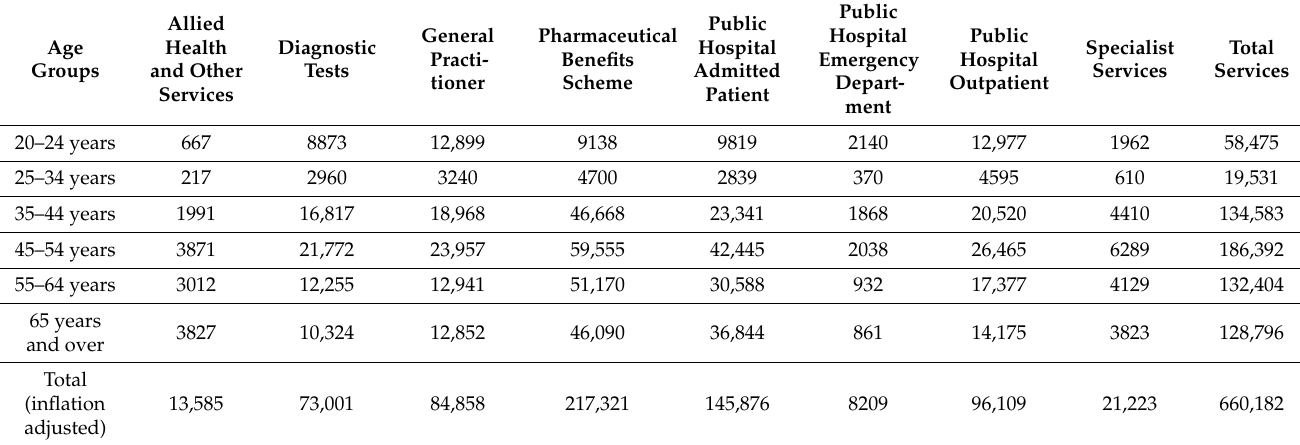
Table A8. Extra costs incurred due to LHL for people diagnosed with CVD in the Blacktown LGA (Domain 9).